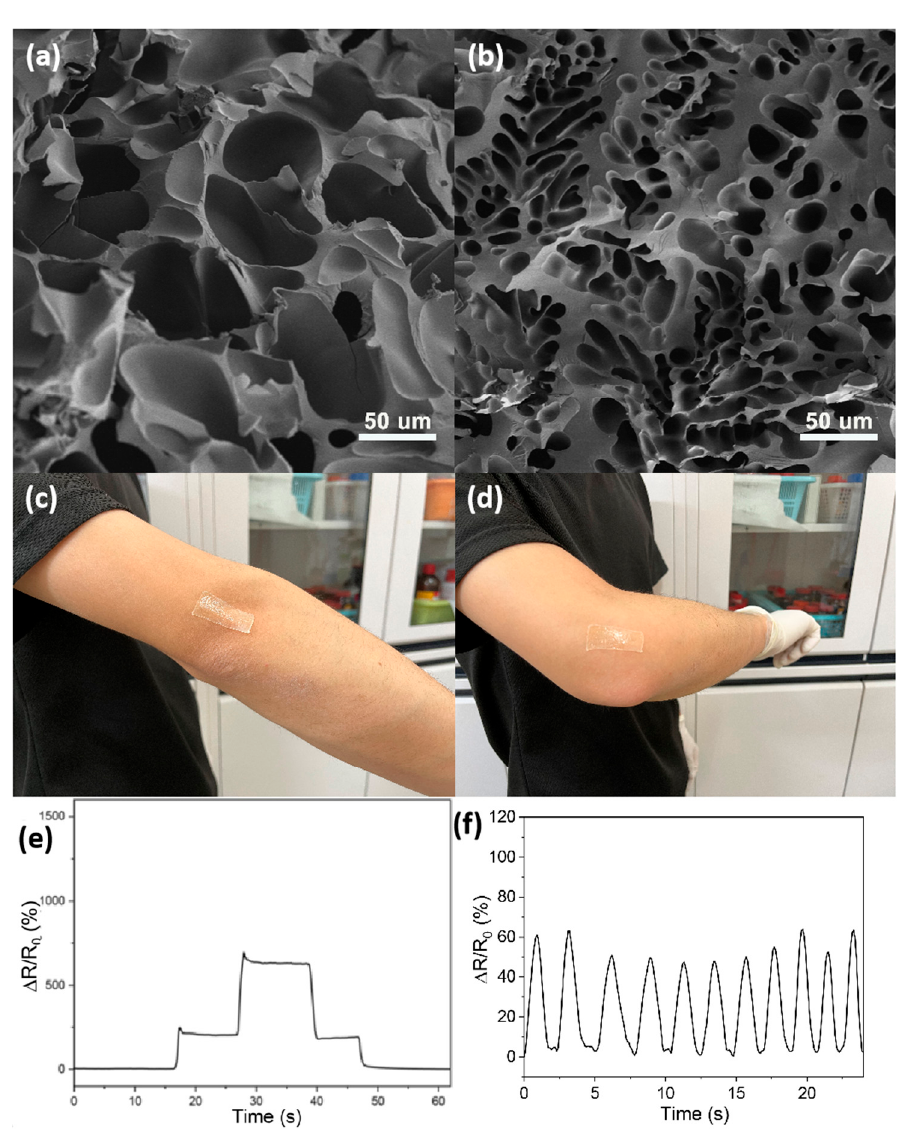
Figure 6. SEM images of ( a ) the PAM hydrogel and ( b ) the P(BHMP-AM)-Zn 2+ hydrogel. ( c ) The hydrogel adheres to the extended human elbow joint. ( d ) The hydrogel deforms as the human elbow bends. ( e ) Change in resistance with an increase in the stress–strain. ( f ) Change in the resistance upon arm movement.